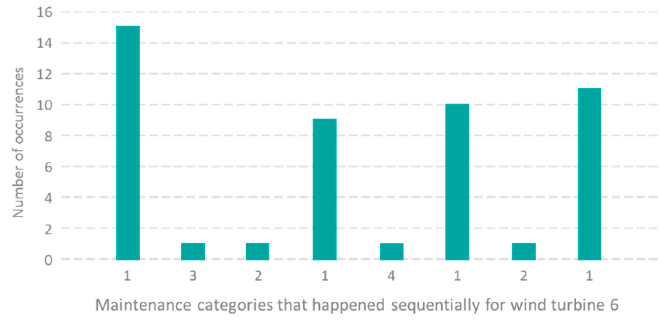
Table 3. The accuracy of the long cycle maintenance time prediction with the rule.